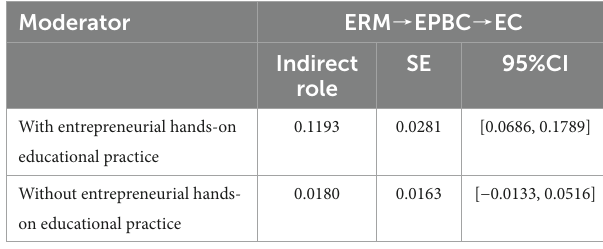
TABLE 6 Results of moderated mediation model